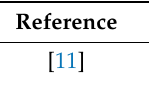
Table 1. Applications of SCG and other agro-wastes as organic an